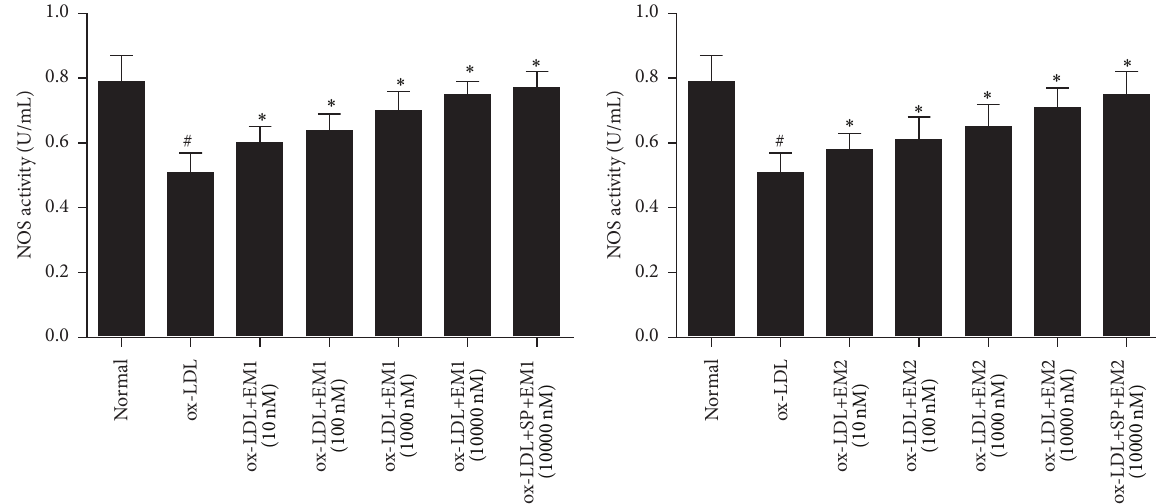
Figure 2: Effect of EM1/EM2 on NOS activity of HUVECs treated by ox-LDL. All data is expressed as mean ± SD. ∗ 𝑃 < 0.05 versus control. # 𝑃 < 0.05 versus